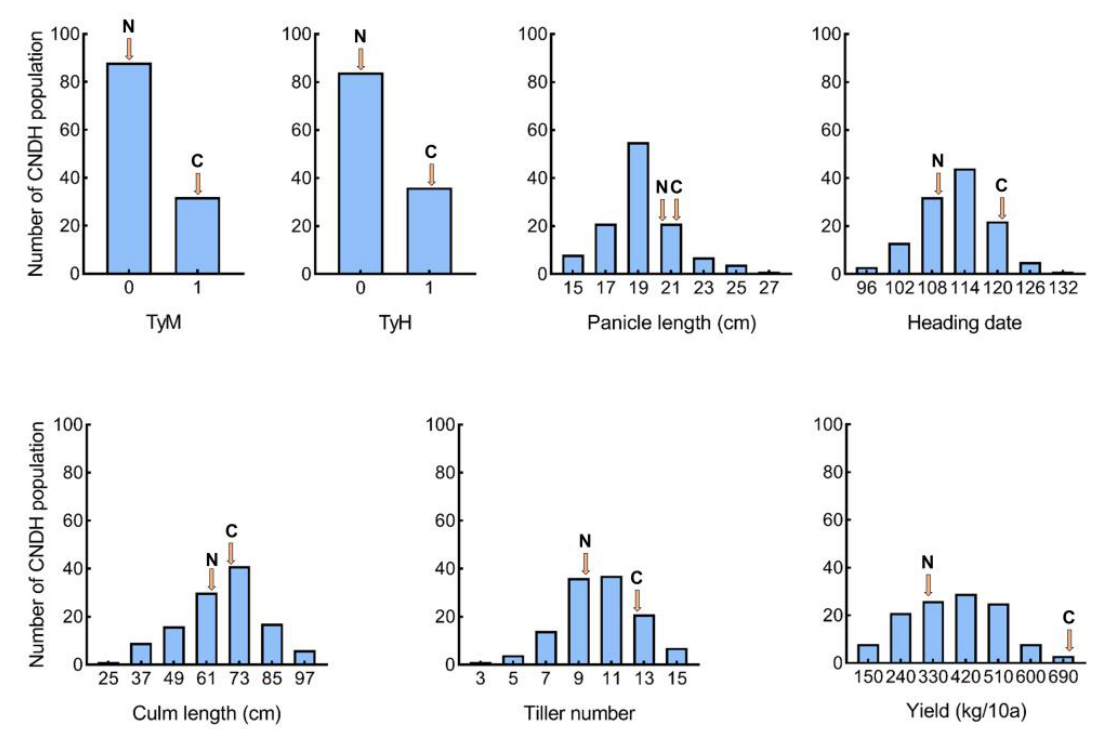
Plants 2023 , 12 , x FOR PEER REVIEW Figure 2. Frequency distribution of phenotypic values of lodging resistance to typhoons in the CNDH population (TyM, Typhoon Maysak; TyH: Typhoon Haishen; C, Cheongcheong; N, Nagdong).